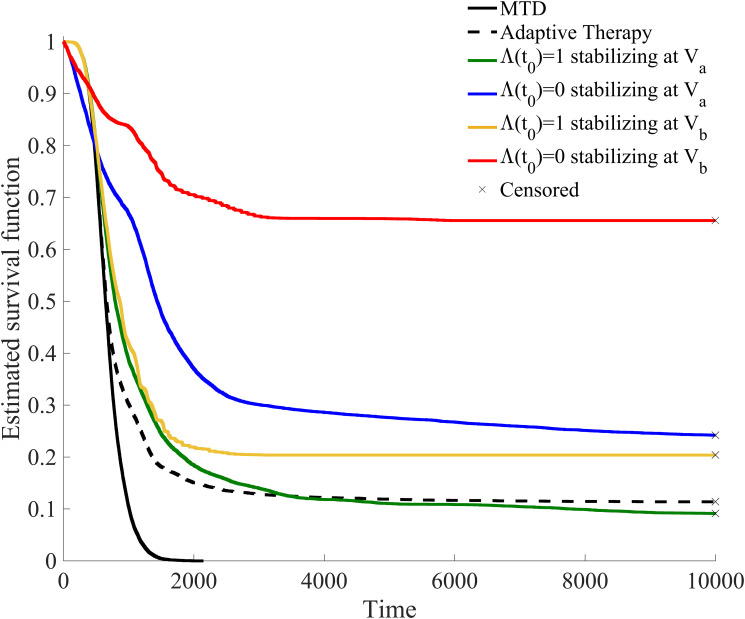
Kaplan-Meier survival analysis for clinically feasible treatment strategies.10, 000 patients were given each of the six clinically feasible treatment strategies. In this way this shows the outcome of 60, 000 simulated patients. Patients that had not yet breached the patient viability constraint by the end of the simulation are labeled as censored.